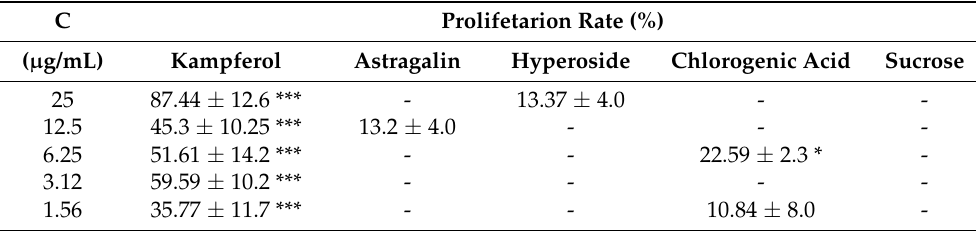
Table 4. The effects of related monomers in TSZE-EA-G6 on the proliferation of